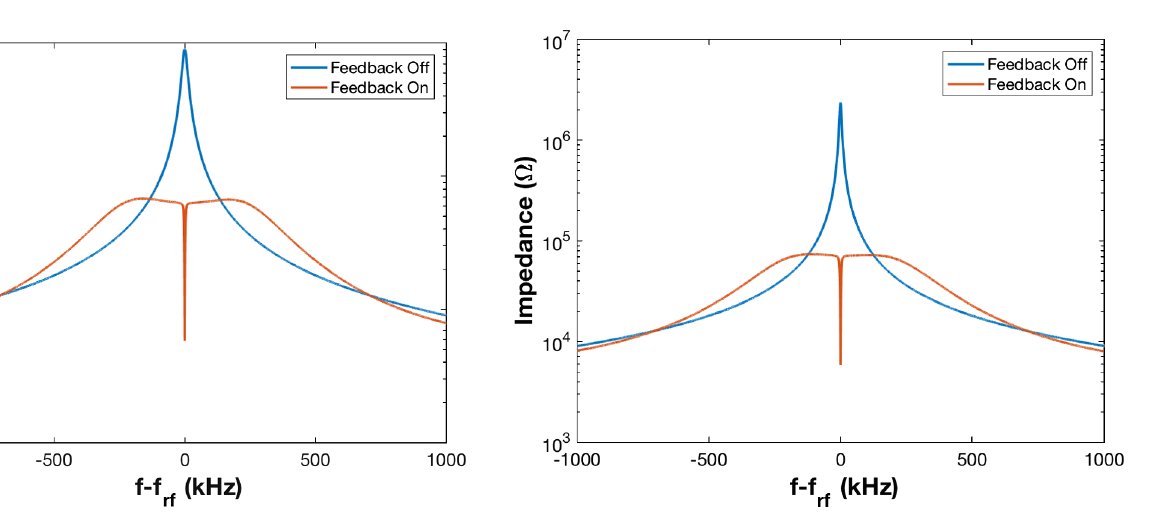
FIG. 5. Modulus of cavity impedance with and without rf feedback (OTFB off). Physics settings: Q L ¼ 60000 , V ¼ 2 MV, cavity on c